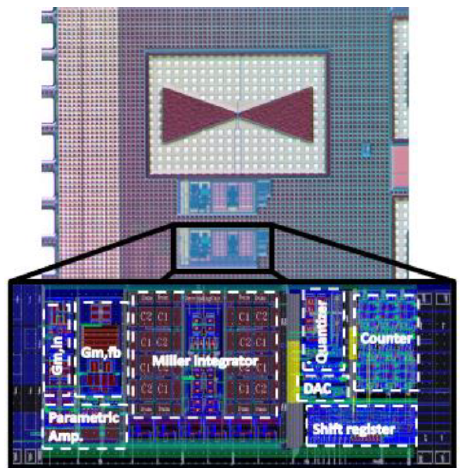
Figure 12. Micrograph of the fabricated THz pixel